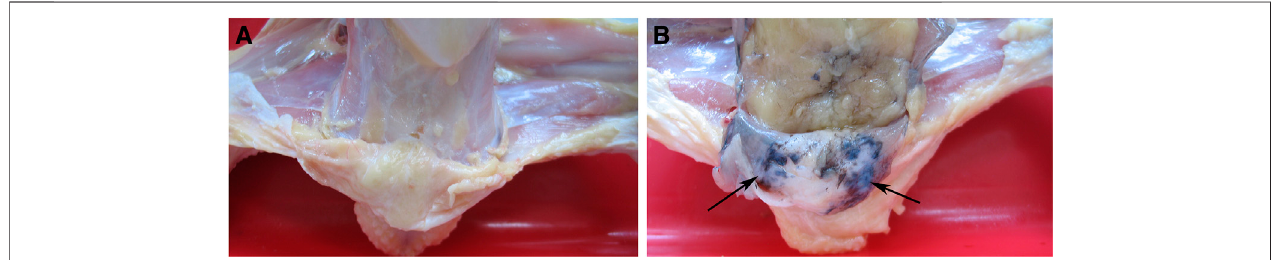
FIGURE 1 | Visceral peritoneum of the normal chicken (A) and HVP chicken (B) .